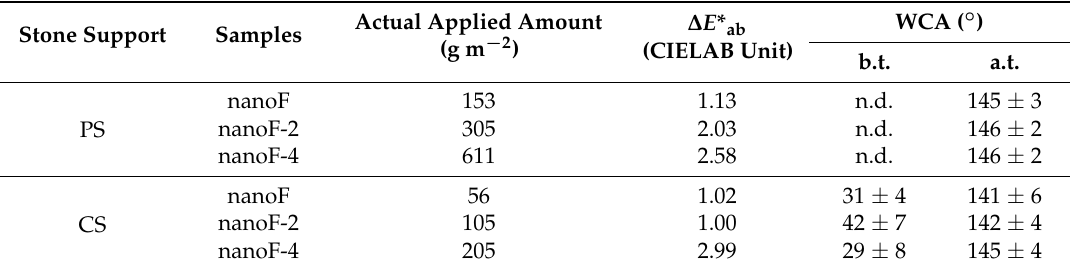
Table 3. Color difference ( ∆ E * ab ) and water–stone static contact angle (WCA), with the relative standard deviations, before (b.t.) and after (a.t.) the treatments with nanoF product.